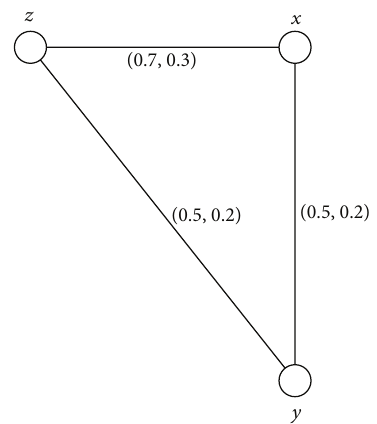
Figure 4: Connected intuitionistic fuzzy